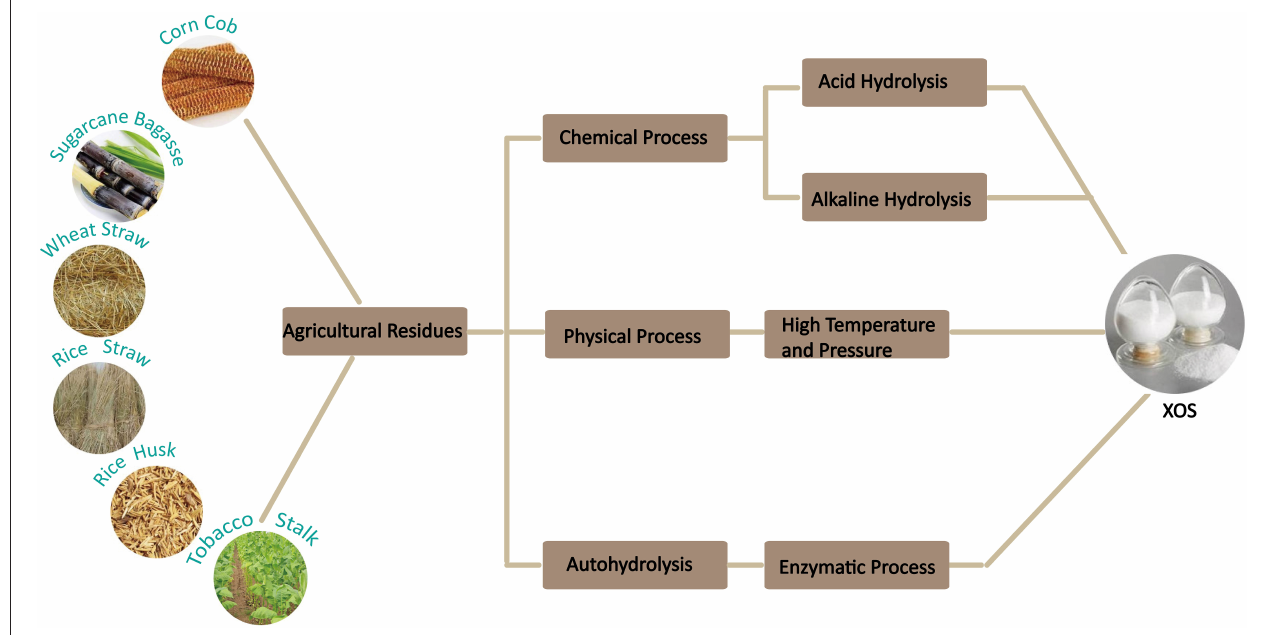
FIGURE 1 | Schematic of XOS production from agricultural